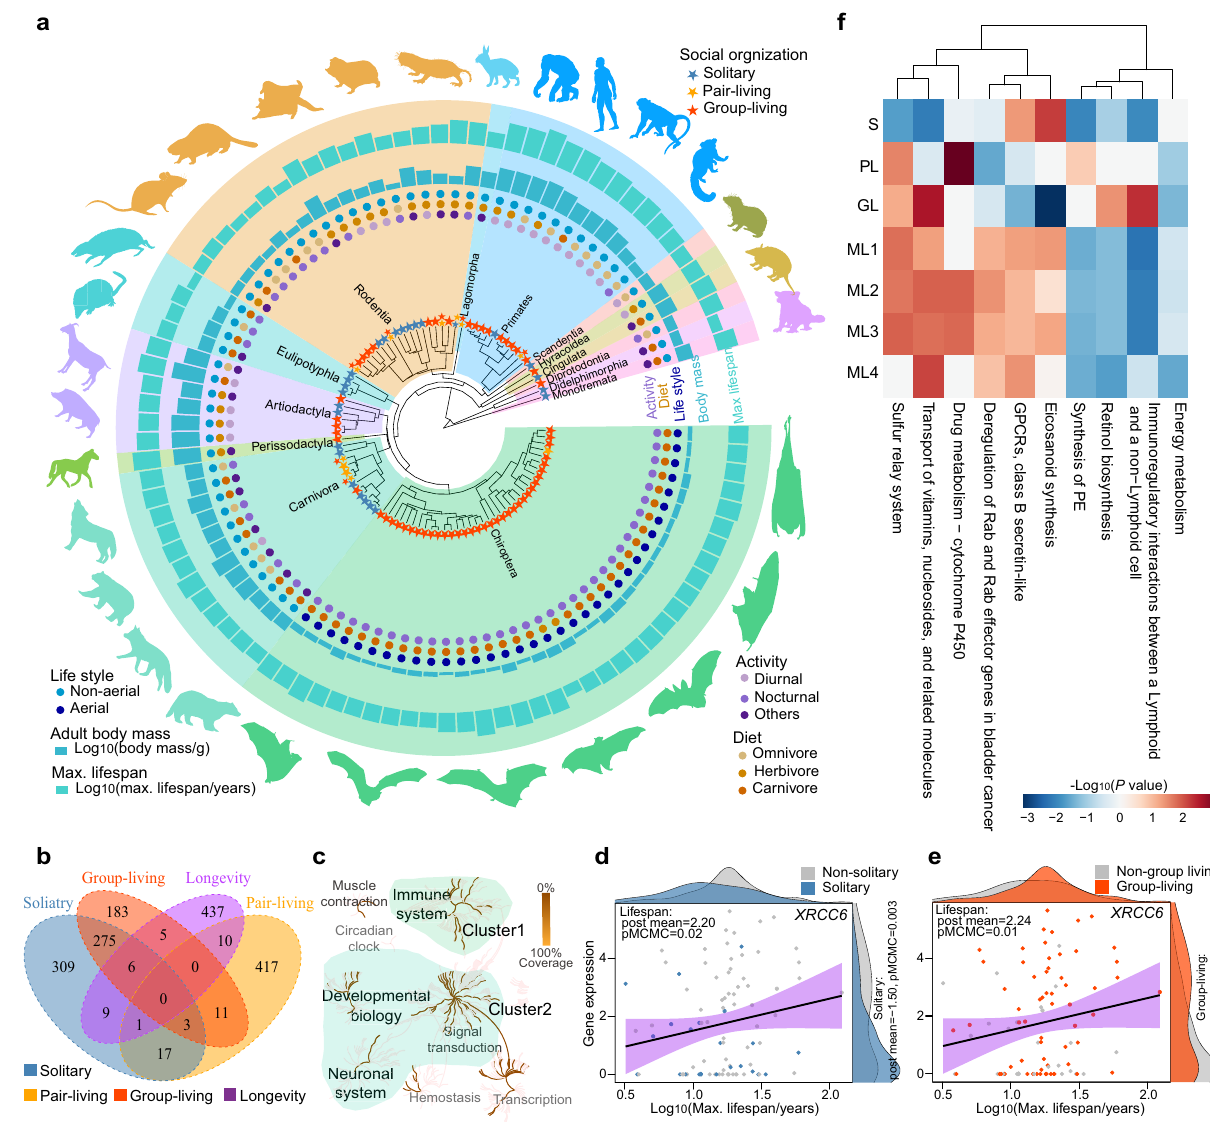
Fig. 2 | Genes and pathways whose expression was correlated with social organization and longevity in 94 mammalian species. a Species ( n =94) with RNA-seq and six life history traits (social organization, activity, diet, lifestyle, adult body mass, and longevity) used in the MCMCglmm analyses. Colorful shadings displaydifferent mammals ’ orders. Silhouette imagesof animals arefrom PhyloPic database[http://phylopic.org/]. b Venndiagramshowingthenumberof signi fi cant overlappinggenesacrosssolitary,pair-living,group-living,andlongevity. c Clusters according to the function of 31 genes that were signi fi cantly associated with social organization and longevity. Each node represents a pathway from the Reactome database 34,35 ;pathwaysinwhichsigni fi cantgeneswereinvolvedarecoloredbrown. Light green shading represents two clusters of gene function. d , e Example of a